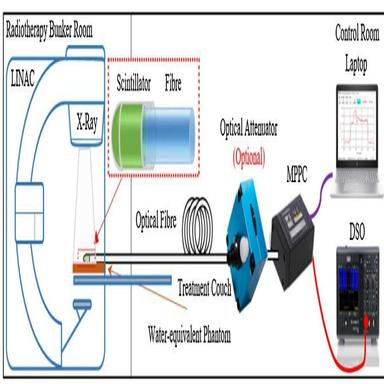
Schematic illustration of the dosimetry system set-up in Clinical environment and an inset of the structure of the sensor.